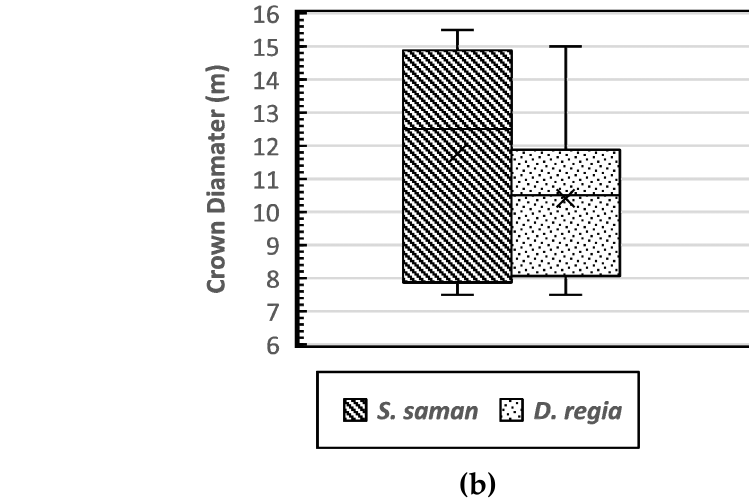
Figure 6. Boxplot of the tree slenderness ( a ) and distribution of crown diameter coefficients ( b ) of Samanea saman and Delonix regia .